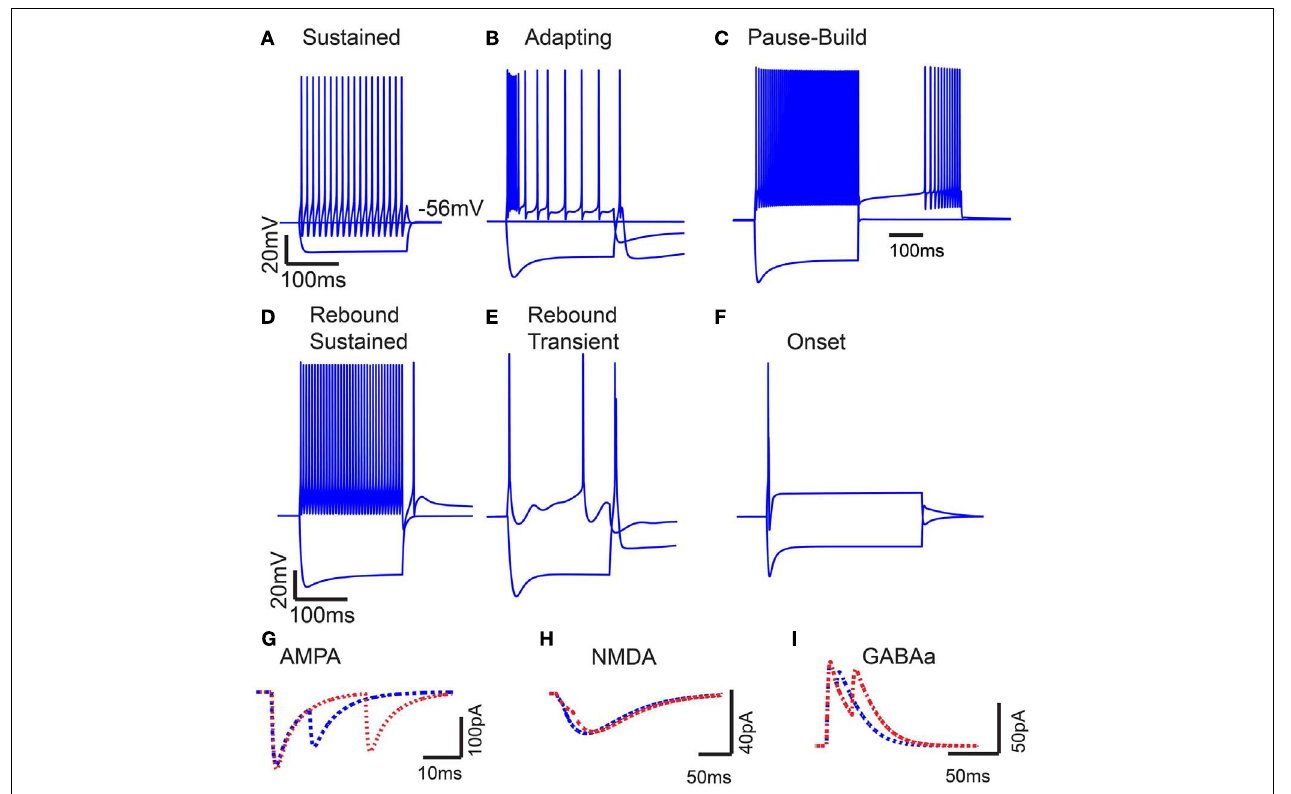
FIGURE 1 | Model intrinsic and synaptic properties. (A) IC Sustained model response to 200pA depolarizing and hyperpolarizing current pulses.Voltage traces measured in mV ( Y -axis) plotted versus time in ms ( X -axis). (B) Adapting model response to 300pA depolarizing and hyperpolarizing current pulses. (C) Pause-build responses to a 500pA depolarizing pulse and a negative 500pA hyperpolarizing current